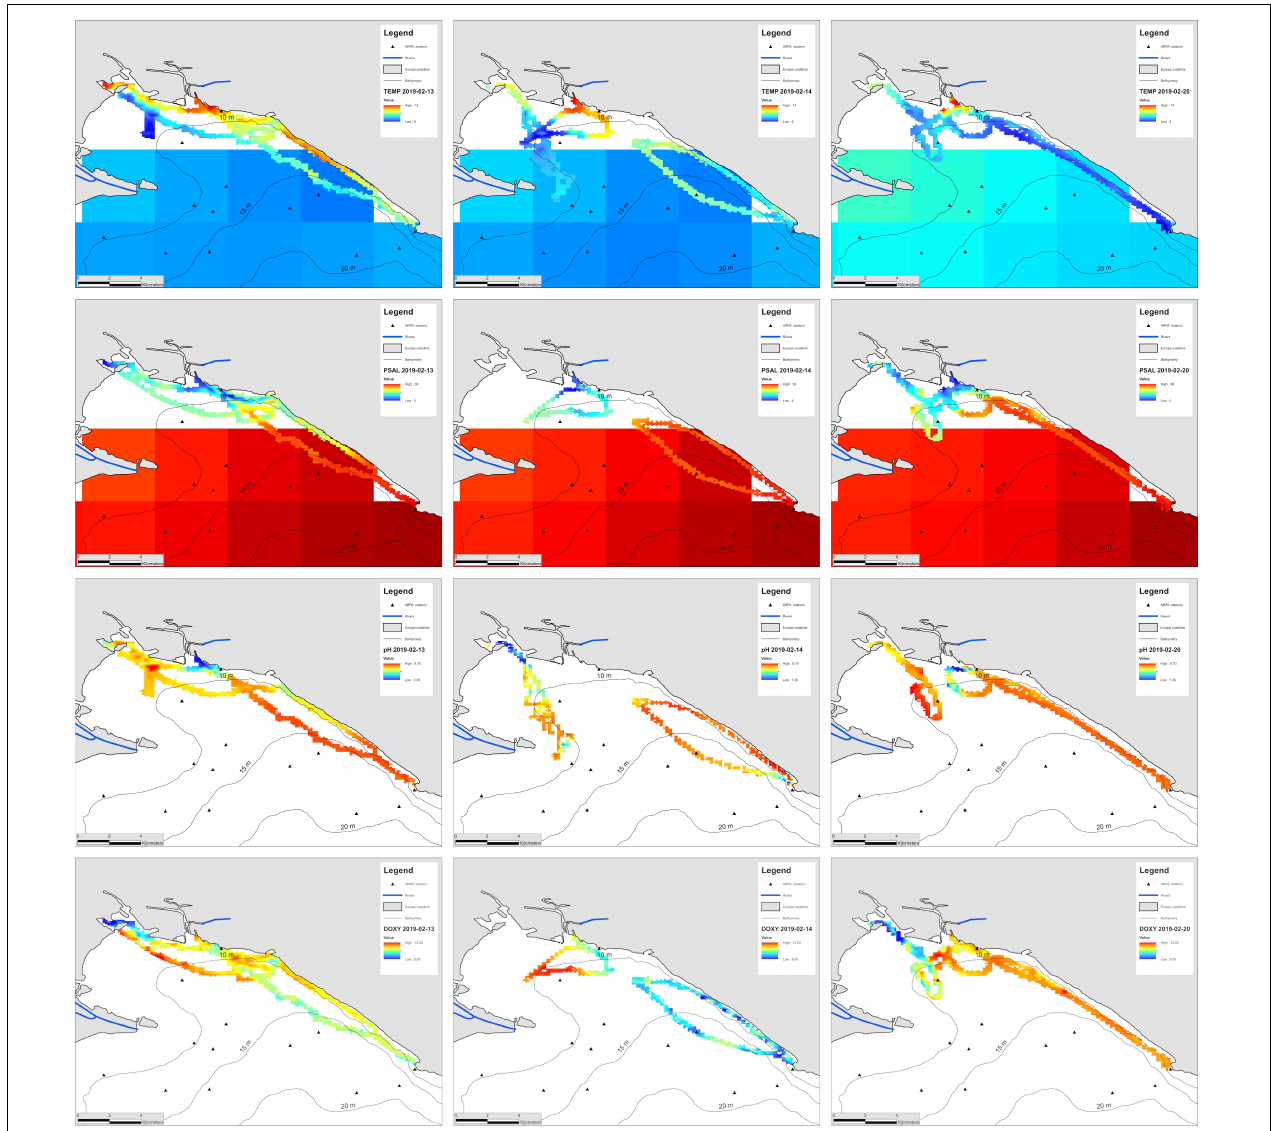
FIGURE 14 | Spatial distribution of the four environmental parameters (Temperature, Salinity, pH, Dissolved Oxygen) considered in the MaDCrow project from three data sources (i) the crowdsourced dataset with a resolution of 200 m by 200 m grid (ii) the Copernicus model with a resolution of 4 km by 4k m grid (iii) the positions of the ARPA stations whose measurements are taken monthly and have to be inter/extrapolated geographically and in time. (A,B) Shows the three datasets superimposed highlighting the improvement of the resolution and coverage of the crowdsourced data. (C,D) Shows only the crowdsourced data since no data is available from the other